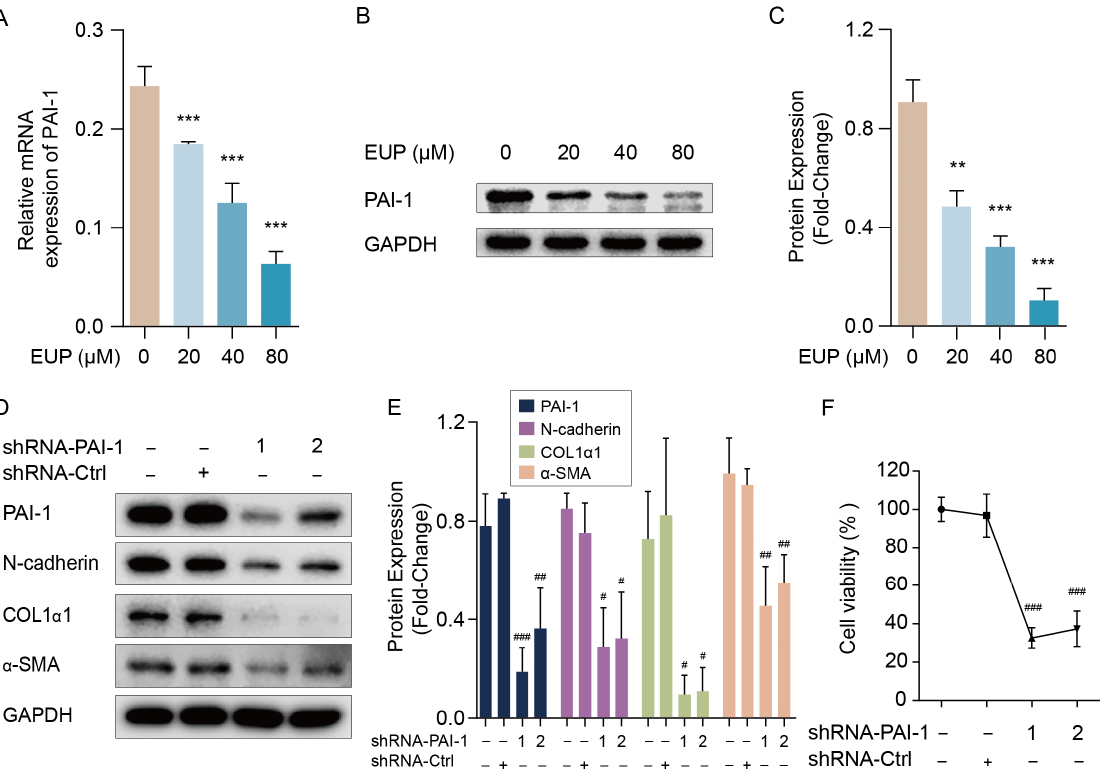
Figure 4. PAI-1 regulates the activation of LX-2 cells involving EMT pathway. ( A ) Relative mRNA expression of PAI-1 in LX-2 cells when treated with eupatilin (mean ± SD, n = 3). ( B ) Western blot analysis of PAI-1 in LX-2 cells. ( C ) Relative protein signal intensity of Figure 4B was quantified as mean ± standard deviation (mean ± SD, n = 3). ( D ) Protein levels of PAI-1, N-cadherin, COL1 α 1 and α -SMA detected by Western blotting. LX-2 cells were transfected with control (shRNA-Ctrl) or shRNA targeting PAI-1 (shRNA-PAI-1 1 and shRNA-PAI-1 2) for 48 h. ( E ) Relative protein signal intensity of Figure 4D was quantified as mean ± standard deviation (mean ± SD, n = 3). ( F ) Cell viability of LX-2 cells transfected with shRNA-Ctrl or shRNA-PAI-1 detected by CCK8 assay (mean ± SD, n = 4). p values are calculated by one-way ANOVA followed by the Tukey’s test. ** p < 0.01 and *** p < 0.001 vs. 0 μ M EUP group. # p < 0.05, ## p < 0.01 and ### p < 0.001 vs. shRNA-Ctrl group.